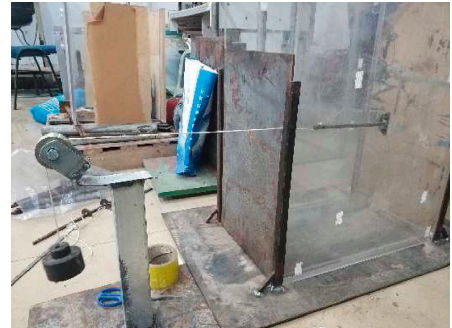
Figure 4: Assembled model.